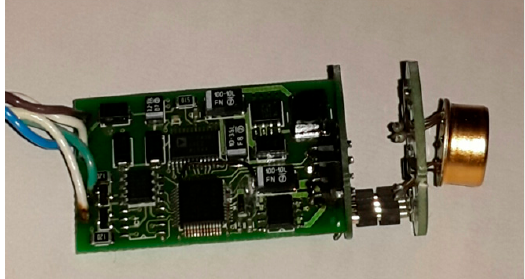
Figure 7. Smart sensor module enabling the stabilization of sensor temperature, humidity compensation, and transmission of information about gas concentration, type of sensor, calibration, etc. in plug-and-play regime. Smart sensor board is 25 mm in